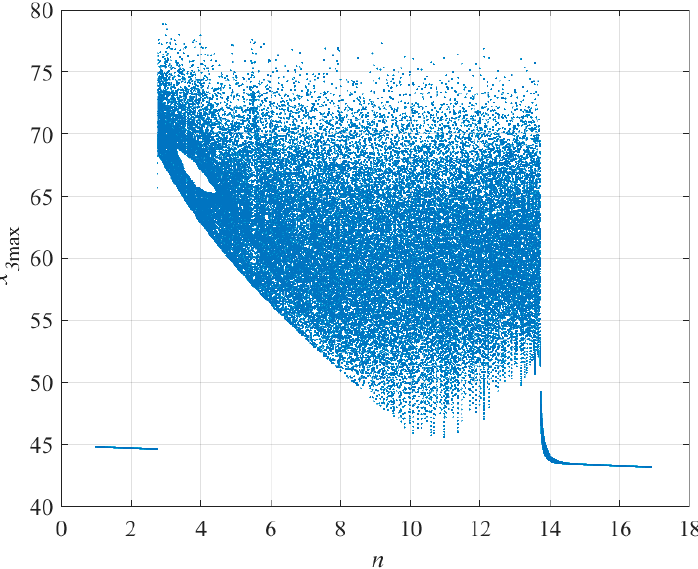
Figure 6. Bifurcation diagram of the proposed fractional-order system by changing parameter n .